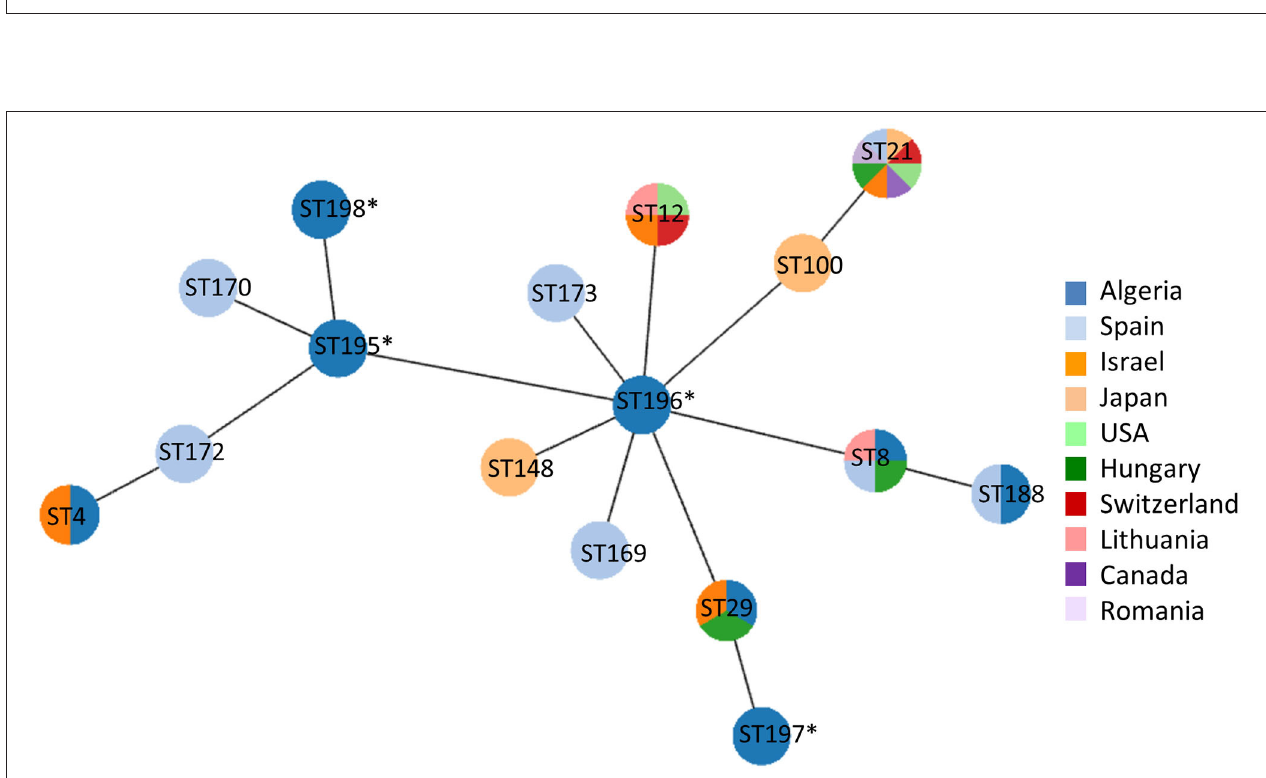
FIGURE 2 | eBURST analysis of the allelic profiles of the Algerian clones (ST4, ST8, ST29, ST188, ST195-198) compared to the closest subtypes found in the PubMLST database. Subtype numbers retrieved from the PubMLST database are indicated in circles, and the new subtypes reported in this study are tagged with an asterisk. Only subtypes close to or common to Algerian isolates are indicated, and their country of origin is color-coded: dark blue, Algeria; light blue, Spain; orange, Israel; light orange, Japan; light green, USA; green, Hungary; red, Switzerland; pink, Lithuania; purple, Canada; lilac, Romania.